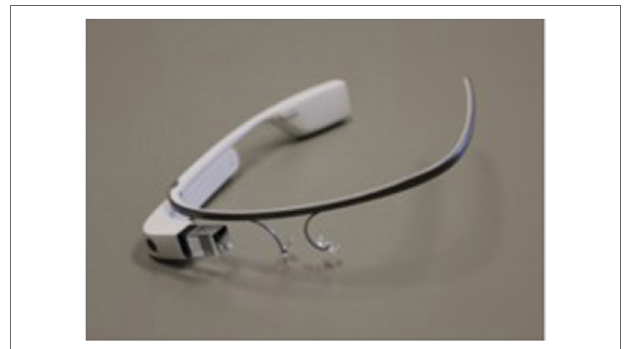
FigUre 1 | The Google Glass